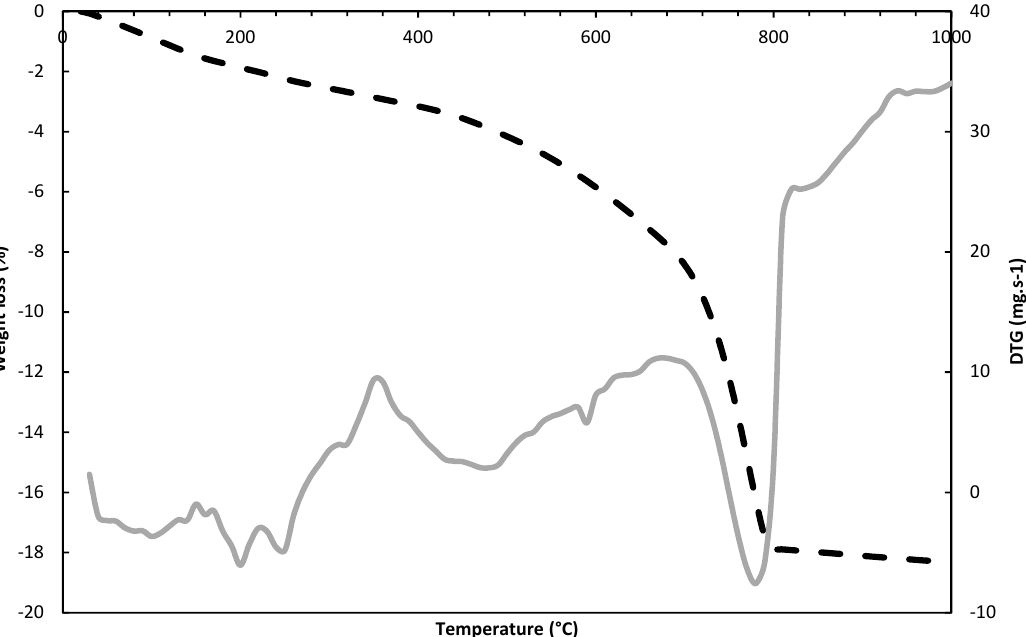
Figure 13. Thermal degradation curve of sample S-004 with heating rate 10 °C/min.